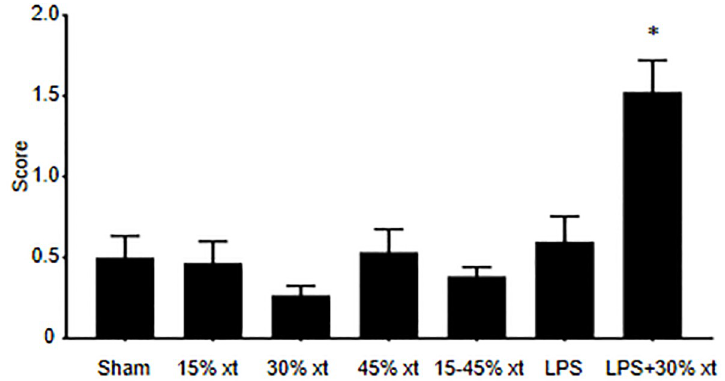
Fig 5. LPS+30% transfusion increases neutrophil-mediated lung injury. Blinded grading of H&E sections for neutrophil infiltration and cell wall thickening from sham (n = 20) animals and animals receiving 15 (n = 15), 30 (n = 30), 45% (n = 15) human erythrocyte transfusion (xt), LPS alone (n = 15) and LPS+30% transfusion (n = 20). Tissues were scored on a scale of 0–4: 0 = normal lungs, 1 = minor lung involvement, 2 = moderate lung involvement, 3 = serious lung involvement, 4 = severe lung involvement. Data are means and standard error of the mean. Statistical analysis was performed using a Kruskal-Wallis test, followed by Mann-Whitney test. � denotes P = 0.05 compared to all other experimental